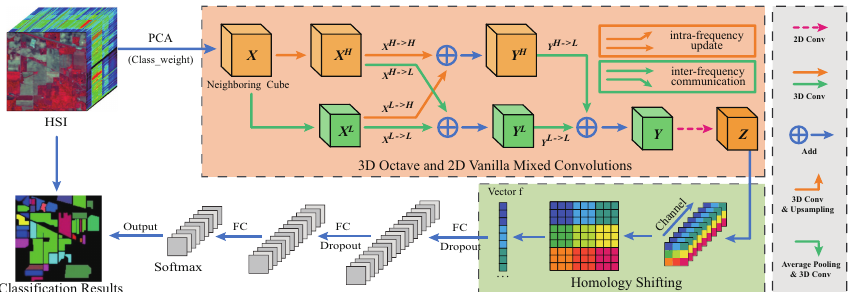
Figure 1. Architecture of the proposed Oct-MCNN-HS. Principal component analysis (PCA) is firstly used to reduce the dimension of the original HSIs. Then, mixed use of 3D octave convolutions and 2D vanilla convolution is proposed for digging deeply into the spatial–spectral features hidden in the principal components. Finally, the feature maps generated by the convolutions are fused through the homology-shifting operation before being sent to the fully connected